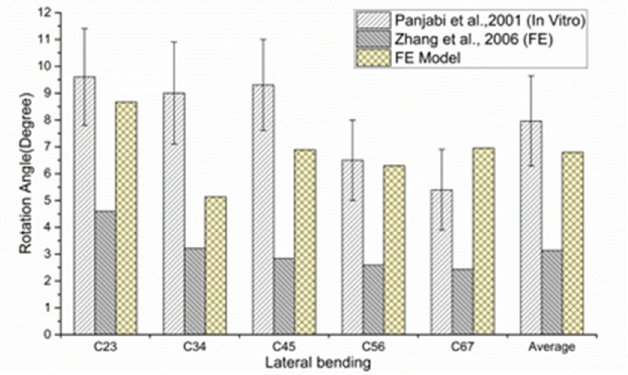
Figure 3. Comparison of the results of the FE model and experimental studies in different segments under flexion (+) and extension ( − ) (data from [3,4,38]).